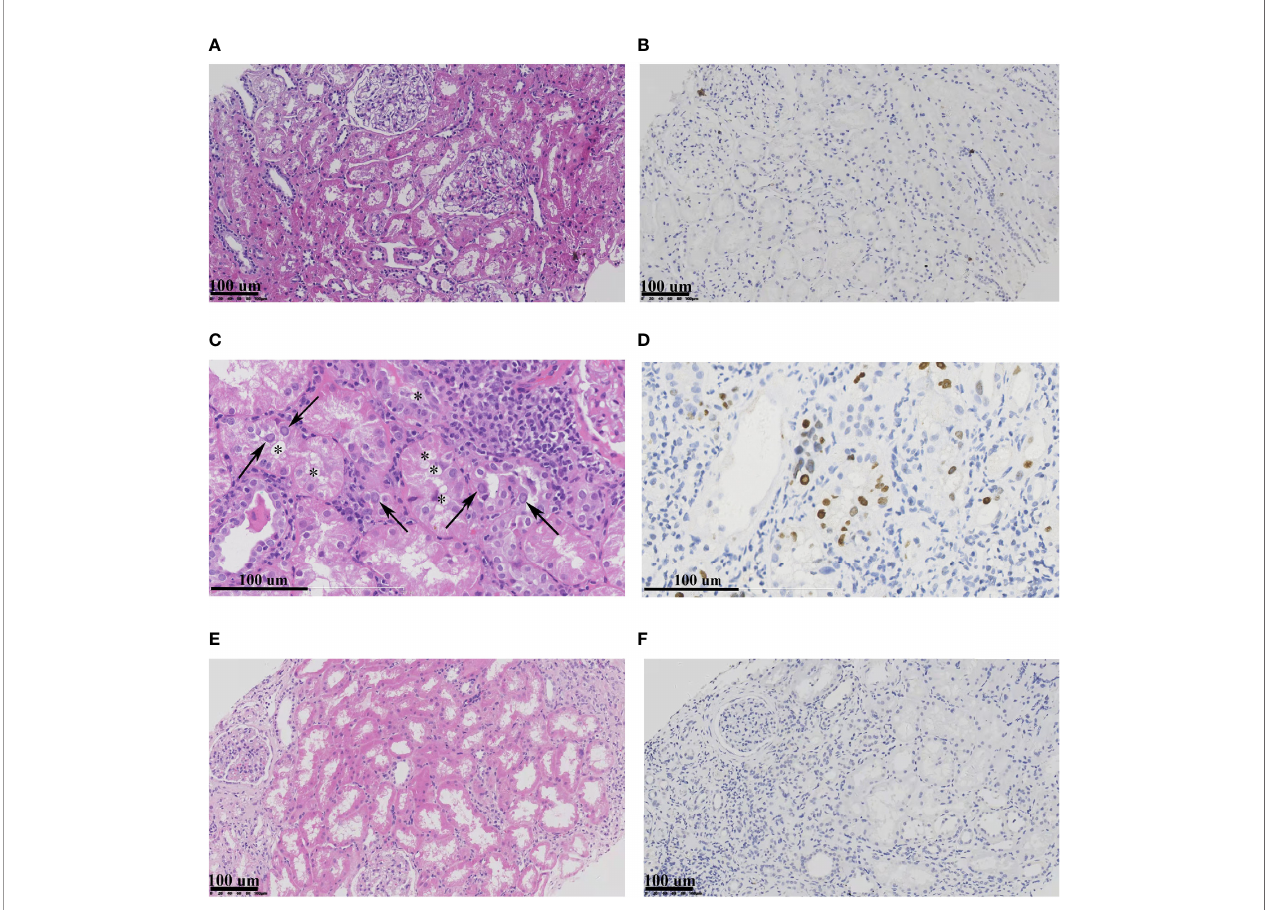
FIGURE 1 | The light micrographs of samples. Compared with stable transplanted recipient (A, B) and resolved BKPyVAN (E, F) , the epithelial cells were swollen with large vacuole (*) within the cytoplasm, and typical intranuclear inclusion (arrows) can be observed in the BKPyVAN recipient 1 (C, D) . In addition, anti-SV40 T-Ag positivity in tubular epithelial cell nuclei. Immunohistochemistry staining (IHC) of panels (B, D, F) corresponding to HE staining (A, C, E) (HE),